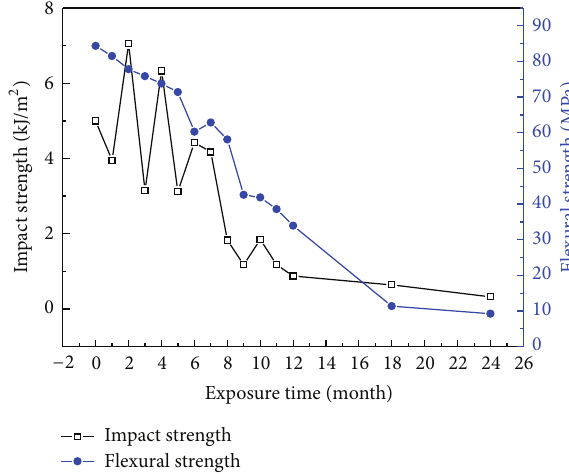
Figure 5: Change of the flexural strength and impact strength of PS with extended exposure time in the environment of Xisha